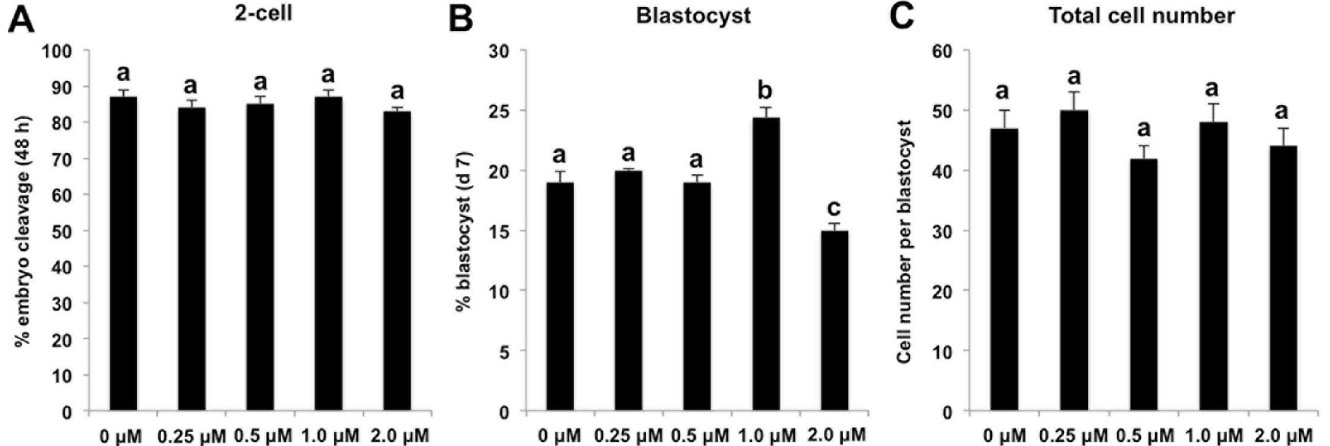
Fig 2. BIX-01294 treatment alone enhances early developmental efficiency of SCNT embryos. SCNT embryos at the pronuclear stage were culturedin PZM-3 supplemented with different concentrations of BIX-01294at 0 (embryo culture water as control), 0.25, 0.5, 1.0 and 2.0 μ M for 24 h, then BIX-01294in different treatment groups were washed out and embryos were culturedin fresh PZM-3 medium until day 7. The effect of G9A inhibitionon the proportionof embryos that reachedthe 2-cell stage within 48 h after activation (A) , proportionof embryos developing to the blastocyst stage (Day 7) (B) and total cell numberper blastocyst (C) are shown. The experiment was repeatedat least three times with 130 embryosper group. All the percentage data are expressedrelative to the numberof 1-cell embryos and are shown as mean ± S.E.M. Valueswith different superscripts across treatments indicatesignificantdifferences ( P <